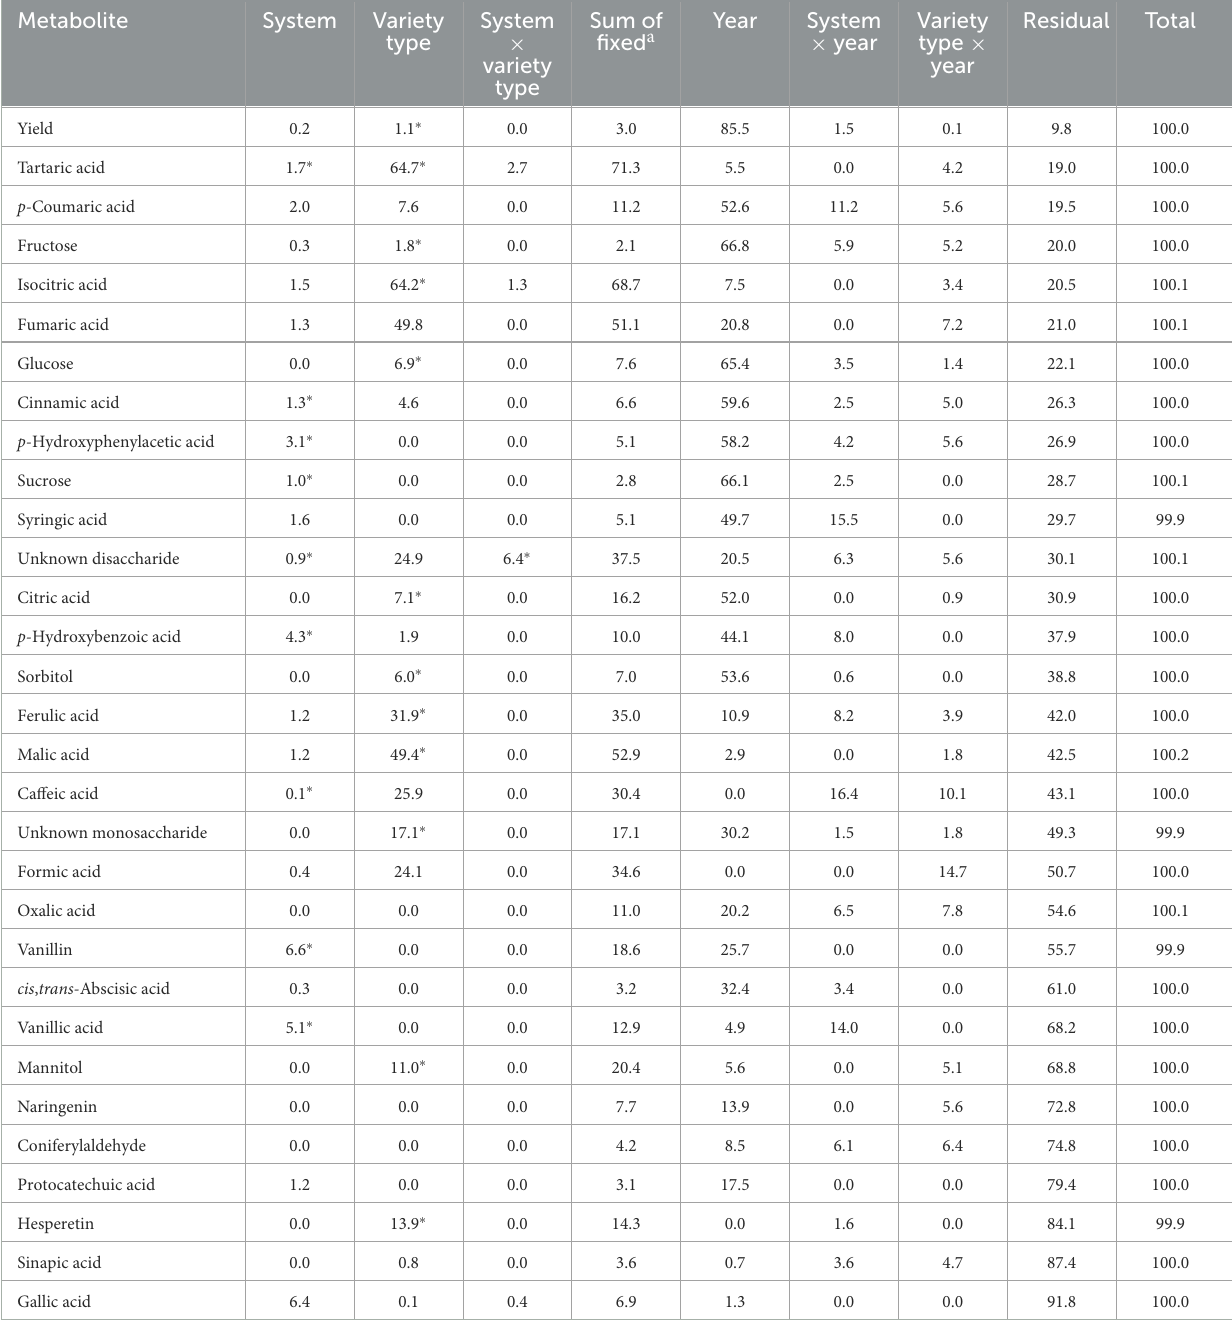
TABLE 2 Percent of explained variation of fixed and random effects. Metabolite System Variety